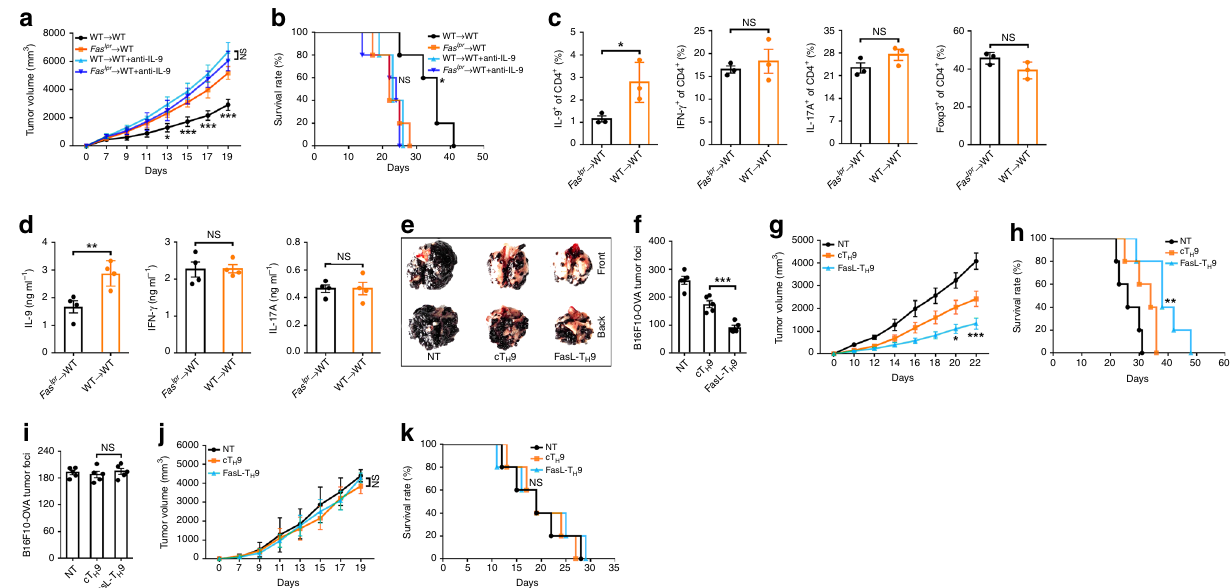
Fig. 6 Fas signaling relates to the antitumor activity of T helper type 9 (T H 9) cells. ( a , b ) Tumor growth ( a ) and survival ( b ) of irradiated WT mice reconstituted with bone marrow cells from wild-type (WT) or Fas lpr mice for 2 months and then subcutaneously injected with LLC-OVA tumor cells with or without intravenous injection of 100 µ g of anti-interleukin-9 (IL-9)-neutralizing antibodies every other day ( n = 5). c Flow cytometric analysis of the frequencies of IL-9 + , IFN- γ + , IL-17A + , and Foxp3 + cells among CD4 + T cells in the tumor-in fi ltrating lymphocytes (TILs) of the mice described in a 20 days after tumor inoculation ( n = 3). ( d ) Enzyme-linked immunosorbent assay (ELISA) measurements of IL-9, IFN- γ , and IL-17A levels secreted by OVA 323 – 339 -stimulated TILs from the mice described in a 20 days after tumor inoculation ( n = 3). e , f Representative lung appearance ( e ) and statistical analysis of the lung tumor foci ( f ) ( n = 5) of WT mice 16 days after intravenous injection of B16F10-OVA melanoma cells with no transfer (NT) or transfer of OT-II cT H 9 or FasL-T H 9 1 and 6 days later. g , h Tumor growth ( g ) and survival ( h ) of WT mice that received a subcutaneous injection of B16F10-OVA cells followed by NT or the intravenous injection of 2 × 10 6 OT-II cT H 9 or FasL-T H 9 1 and 6 days later ( n = 5). i Lung tumor foci of Il9r − / − mice 16 days after intravenous injection of B16F10-OVA melanoma cells with NT or transfer of OT-II cT H 9 or FasL-T H 9 1 and 6 days later ( n = 5). j , k Tumor growth ( j ) and survival ( k ) of Il9r − / − mice that received a subcutaneous injection of B16F10-OVA cells followed by NT or intravenous injection of 2 × 10 6 OT-II cT H 9 or FasL-T H 9 1 and 6 days later ( n = 5). NS, not signi fi cant; * P < 0.05, ** P < 0.01, and *** P < 0.001 (unpaired Student ’ s t test: a , c , d , f , g , i , and j ; log-rank test: b , h , k ). Compared with the Fas lpr → WT mice in a , b ; compared with cT H 9 in g , h , j , and k . Representative results from three independent experiments are shown (mean and